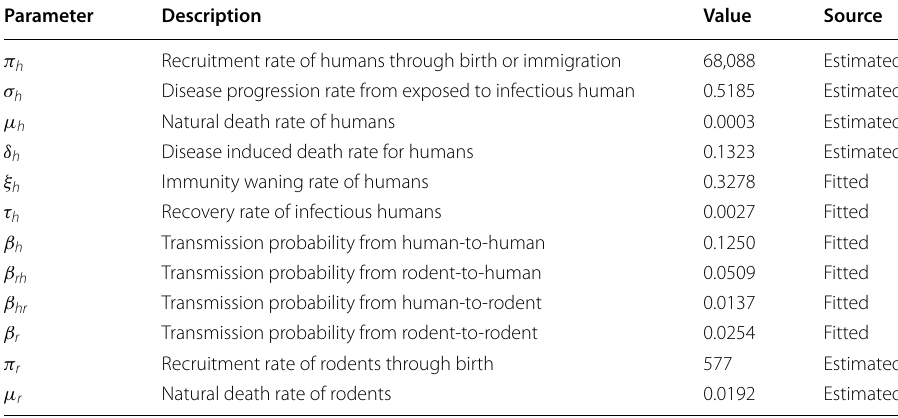
Table 2 Parameter values for the Lassa fever model (1)